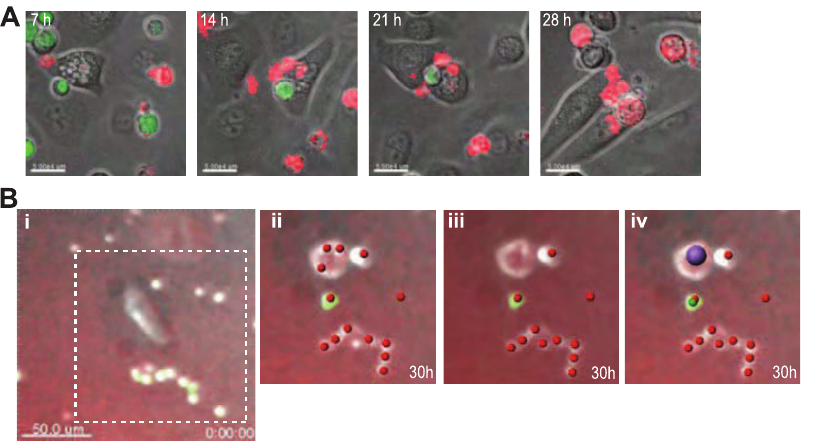
Figure 2. Imaging of CTL and KC targets. A . Series of still confocal microscopic images from Movie S1 of a single field over 30 hours. CD8 + T cells (green) attach to KC after 7 h of co-culture and cause apoptosis (red) at 21 h. Overlay images were from brightfield and fluorescence channels, acquired using a 6 25 objective lens, mean intensity projection of a Z-stack of 5 confocal images of 2 m m each. (Bar, 50 m m) B . Analysis of epifluorescent imaging of CTL and KC co-cultures by software spot detection. Merged views of brightfield, rhodamine filter and GFP filter are shown in each frame at time 0 (i) and at 18 h (ii–iv). i. At t=0, a KC and several smaller green T cells can be seen. ii. Spot detection without correction, using parameters: Red + , size 7 m m. iii. Spot detection after manual correction for adjacent spots. iv. Spot detection using parameters: Green + , size 7 m m (green); red channel + , size 7 m m (red); and including Red + , size 15 m m (purple).